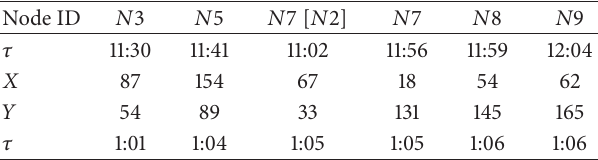
Table 3: Node 𝑁2 is the Sybil, acting as 𝑁7